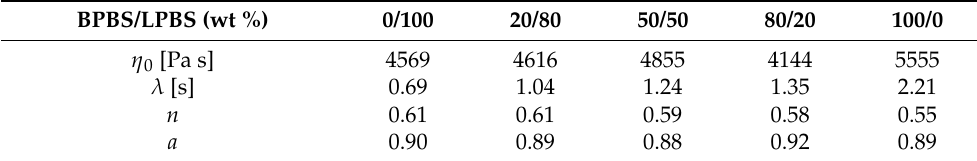
Table 5. Carreau–Yasuda parameters for LPBS, BPBS, and their blends at 150 ◦ C. BPBS/LPBS (wt %)